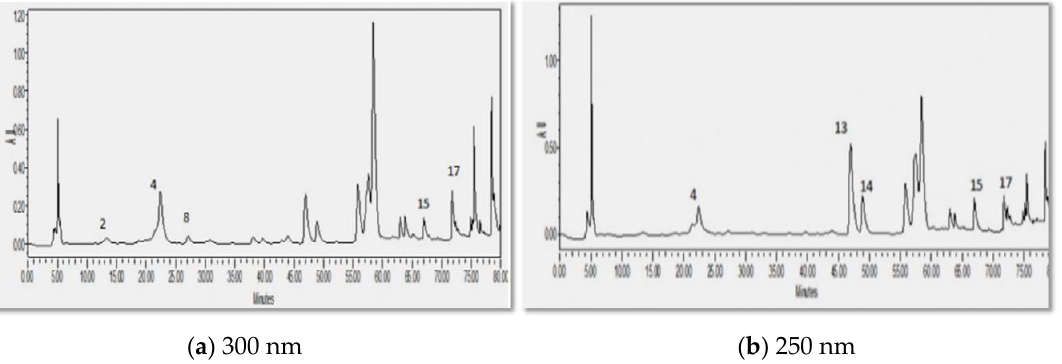
Figure 3. HPLC chromatogram of V. iphionoides extract analyzed using RP-HPLC method at two different wavelengths, ( a ) 300 nm and ( b ) 250 nm.